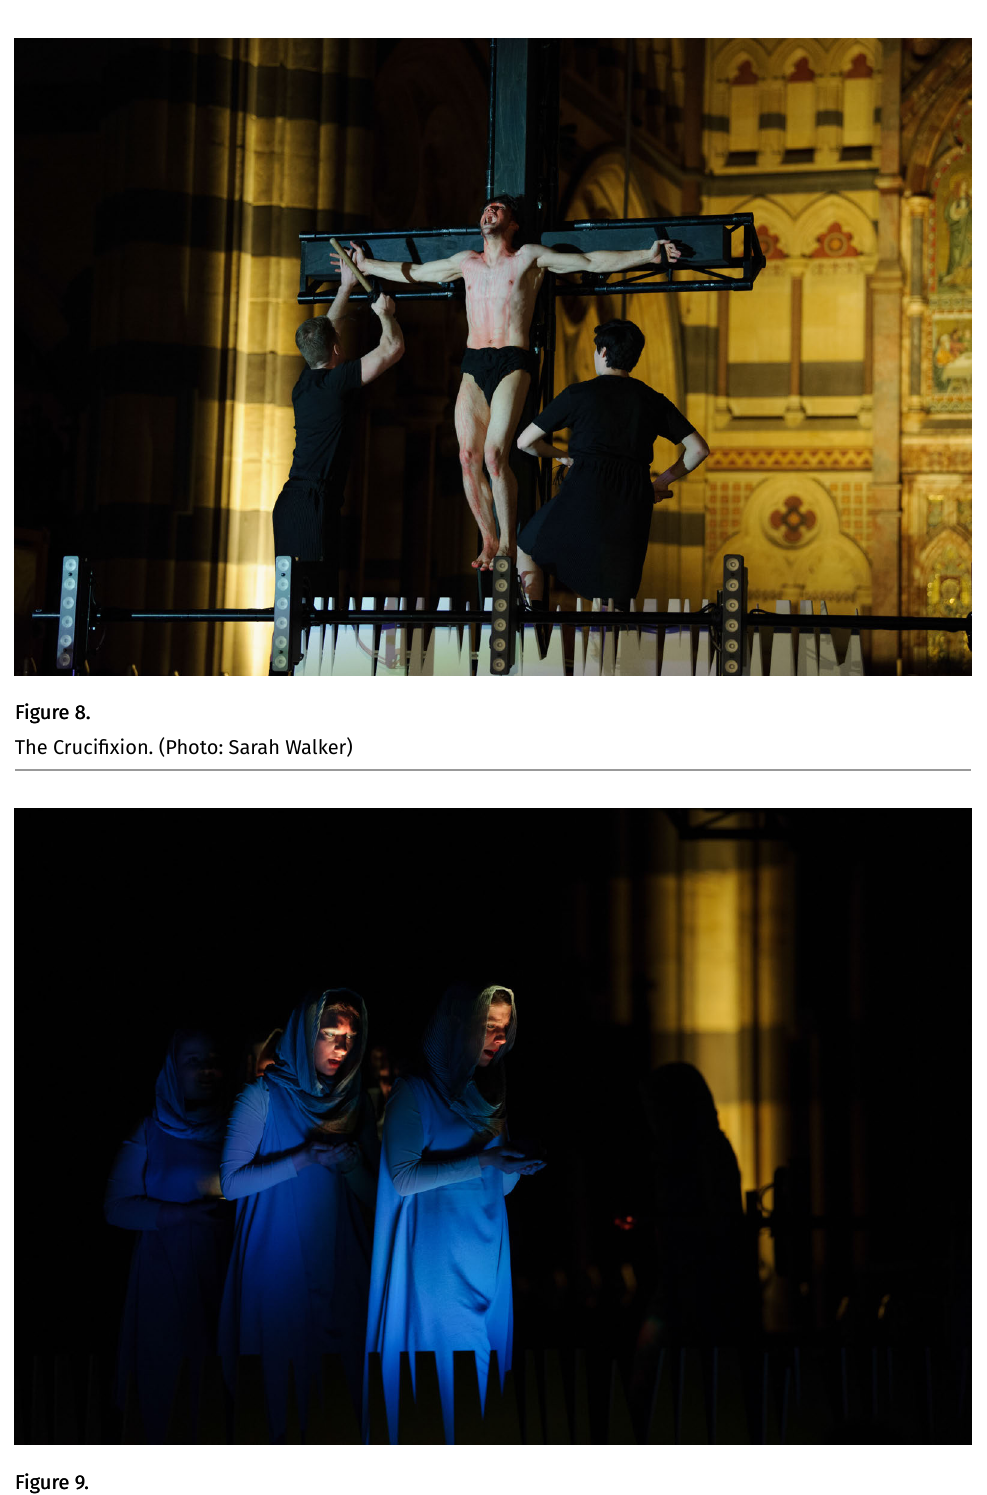
FFigigururee 99.. The Vigil. (Photo: Sarah